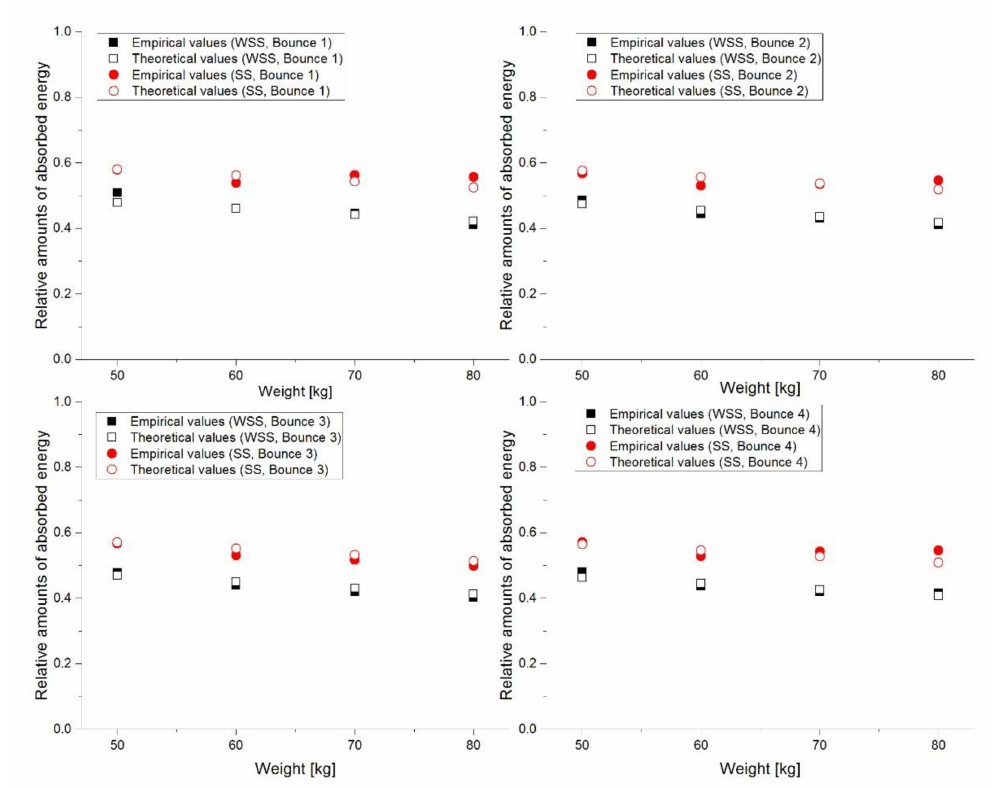
Figure 8. Empirical and theoretical values (Model